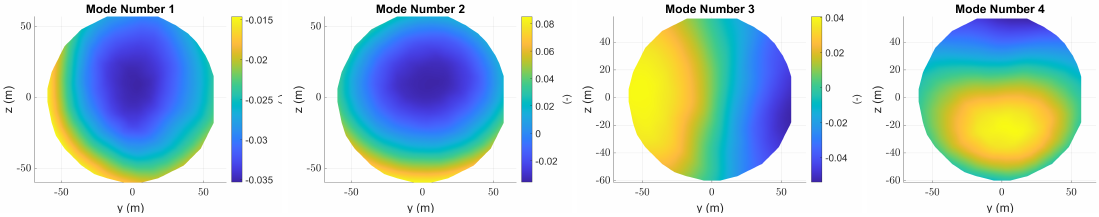
Figure 5. POD modes 1 to 4 of the line-of-sight ( v los ) measurements for the CBL